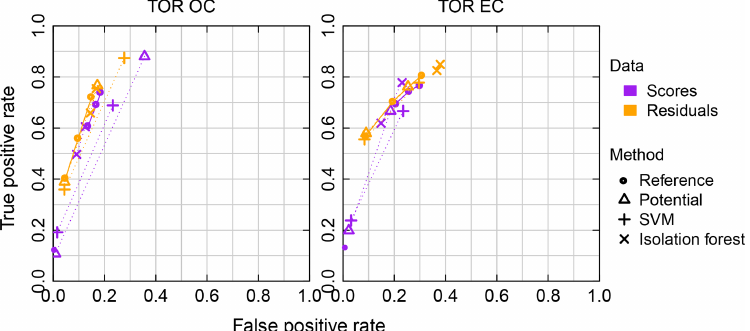
Figure 14. Receiver operating characteristic (ROC) curves for the 2013 IMPROVE data set. Symbol colors are grouped according to the data used for detection (either scores T or residuals E ). Symbol shapes indicate method of estimation. “Reference” denotes Hotelling’s T 2 statistic for scores and the Q (X) statistic for residuals, for which three open circles are shown for the α = { 0 . 1 , 0 . 05 , 0 . 01 } significance levels. The filled purple symbol indicates the performance determined by the maximum T 2 of the 2011 IMPROVE test set, as originally used by Reggente et al. (2016). For other methods, two symbols are drawn and connected by dotted lines to indicate the solution with the highest accuracy (fraction classified correctly) and the solution that lies close to the coordinate ( 0 , 1 )